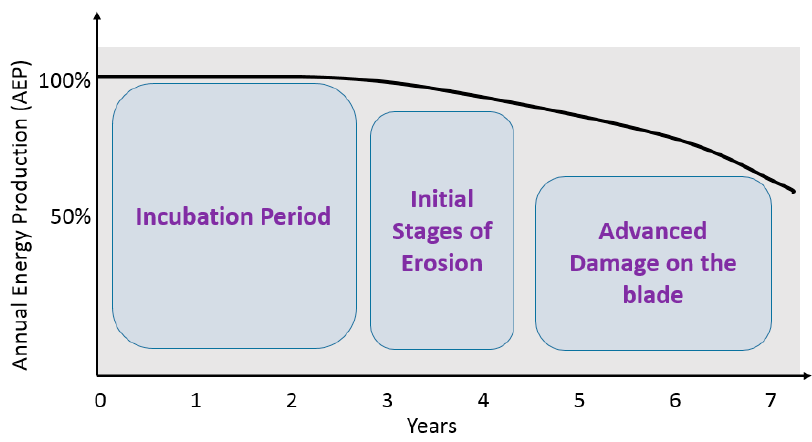
Figure 5. Annual energy production loss over turbine lifetime. Redrawn from [44].